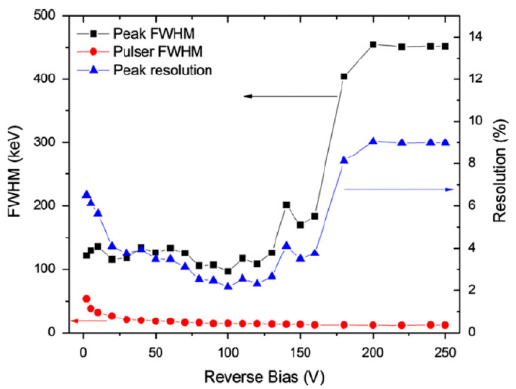
Figure 13. Variation of 5.48 MeV alpha peak FWHM, pulser peak FWHM, and alpha peak percentage resolution as a function of detector bias voltage.